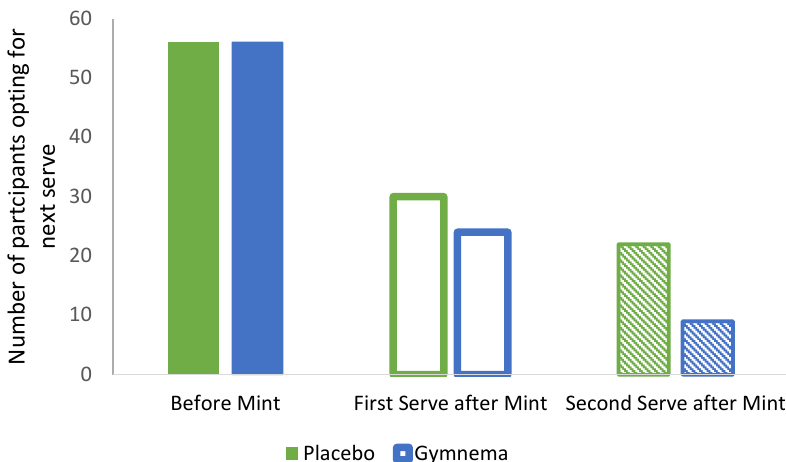
Figure 4. Number of participants opting for further servings of a high-sugar sweet food (chocolate) before and after mint consumption.